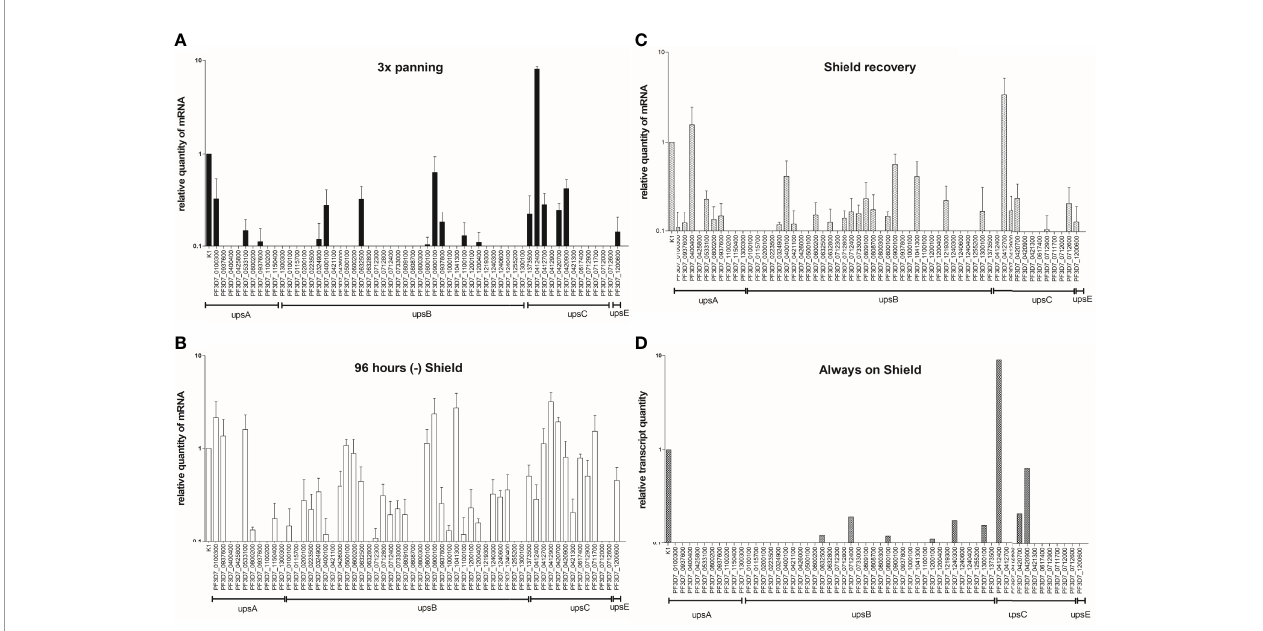
FIGURE 3 | var gene transcription analysis during a transient knockdown in PfAP2-O-GFP-HA-DD24 parasites. (A) RNAs extracted from NF54::PfAP2-O-GFP-DD24 parasites grown in the presence of Shield-1, and panned three times over CHO-CD36 cells were analyzed by RT-qPCR using t-seryl ligase ( “ K1 ” ) as an internal control transcript, as described in Methods . (B) var transcript pro fi le after 96 h incubation of parasites without Shield-1. (C) var transcript pro fi le in parasites after re- establishment of PfAP2-O for two reinvasions (96 h). (D) var transcription pro fi le in parasites never submitted to silencing of PfAP2-O (Always on Shield-1, at the end of the knockdown experiment). The data represent results from three independent experiments and error bars indicate the standard deviation between